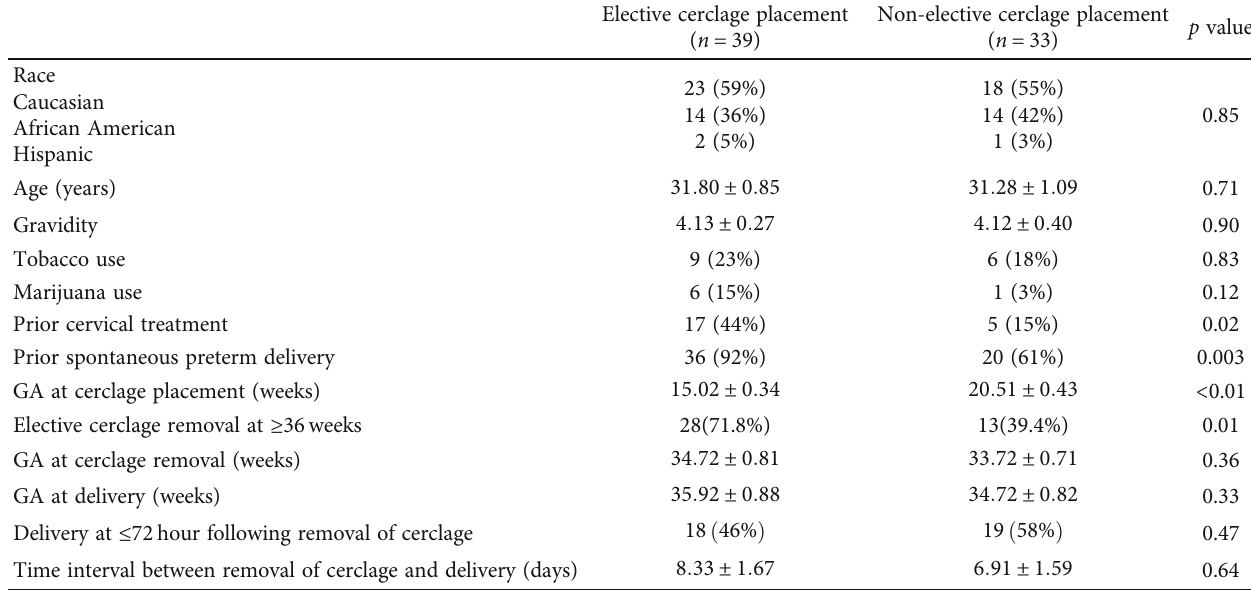
Table 1: Comparison of maternal demographic data and outcome variables in women treated with elective versus non-elective cerclage.